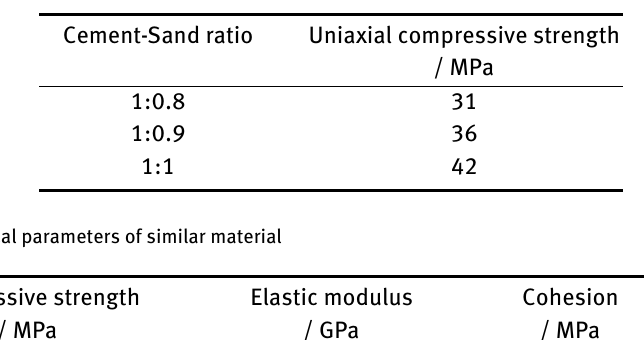
Table 1: Uniaxial compressive strength of each mix ratio Cement-Sand ratio